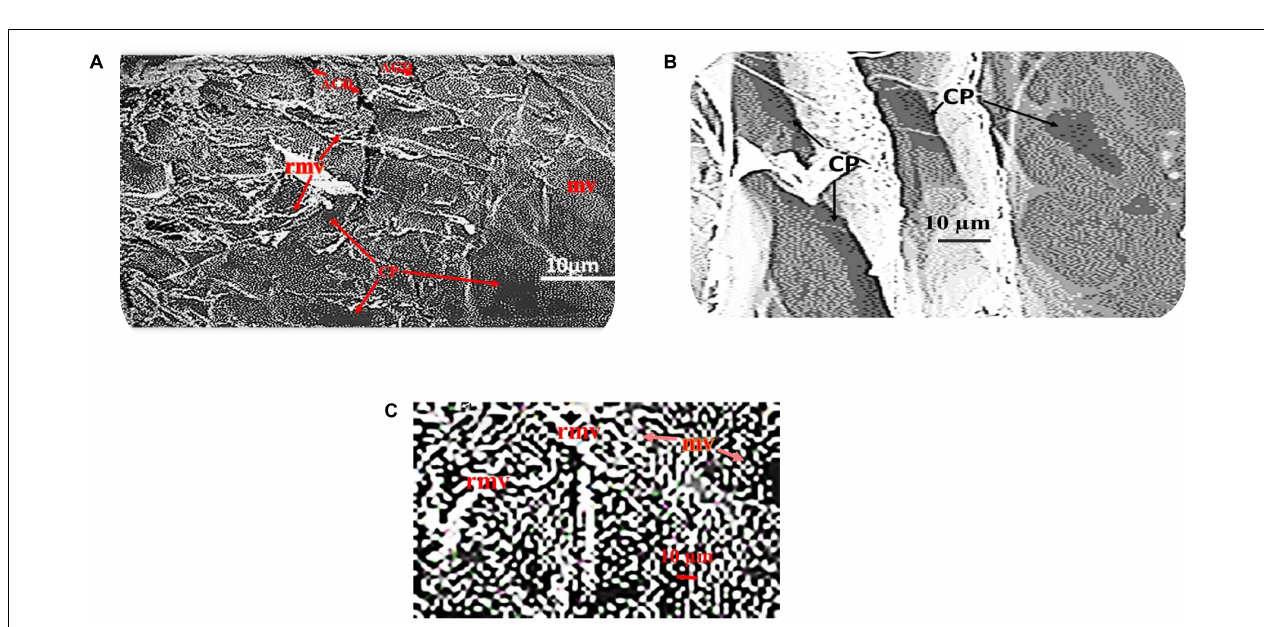
FIGURE 3 | (A) A translucent PW-HAM wound dressing unpacked from the DuPontTM Tyvek R (cid:13) medical grade packaging paper and sterile Nucril coated laminated aluminum foil pouch. (B) A light micrograph showing a smooth surface view of the matrices of the processed PW-HAM wound dressing. (C) A light micrograph shows fibrous nature (unique long and short fibers) of the matrices of the processed PW-HAM wound dressing.